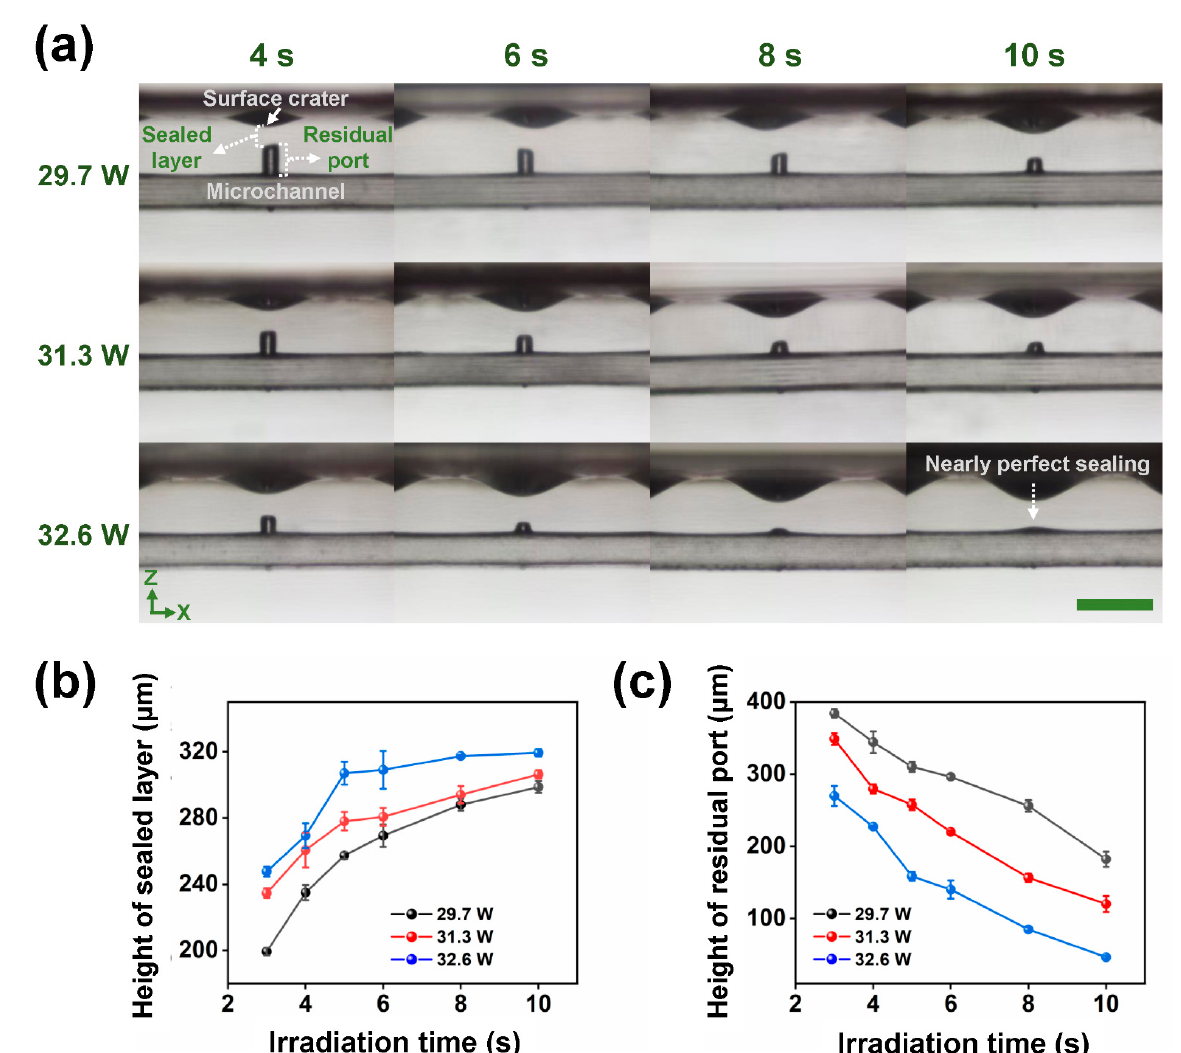
Figure 2. ( a ) Cross-sectional optical micrographs of a microchannel structure with an extra-access port after defocusing CO 2 laser irradiation at different laser powers (29.7, 31.3, and 32.6 W) and irradiation times (4, 6, 8, and 10 s). After CO 2 laser irradiation, an open extra-access port can be sealed to form both a sealed layer while a surface crater is created and a part of the port residues depending on specific conditions. Scale bar represents 1 mm. ( b ) Height of sealed layer versus CO 2 laser irradiation time under different laser powers. ( c ) Height of residual port versus CO 2 laser irradiation time under different laser powers.